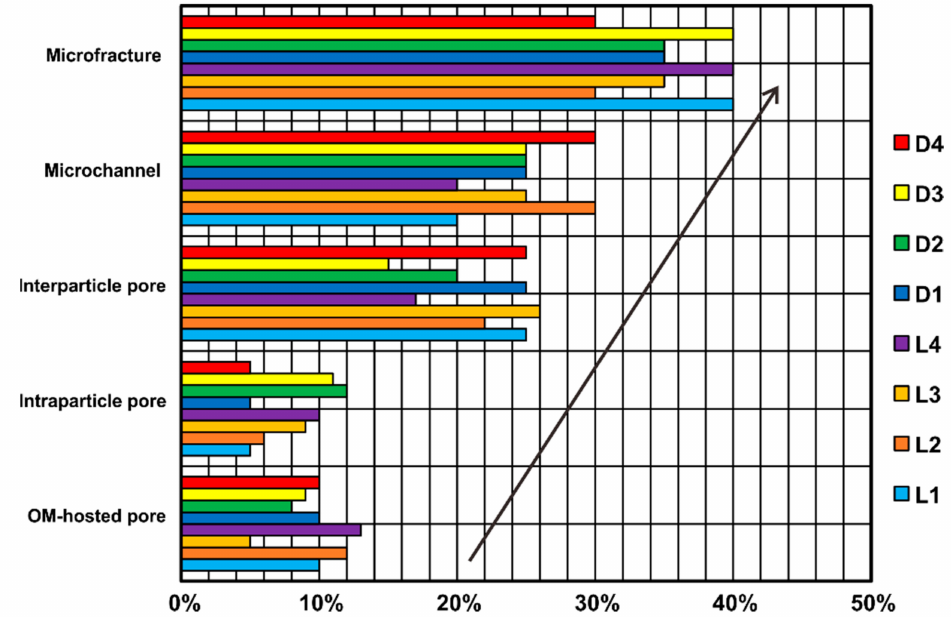
Figure 3. Relative abundance of pore types within all shales. Fracture-related pores (e.g., microchannels and microfractures) account for the 60% of the total pore types, mineral-hosted pores (e.g., interparticle pores and intraparticle pores) account for ~30%, and OM-hosted pores account for